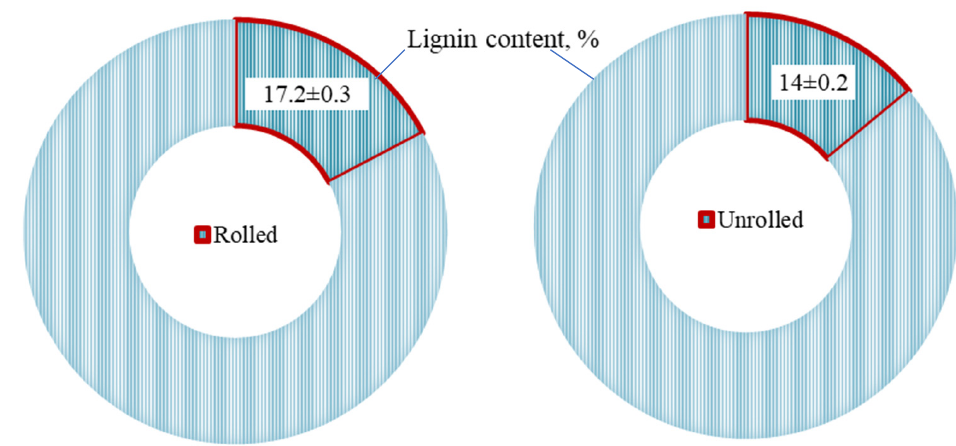
Figure 8. Lignin content in cannabis residues depend on treatment method.